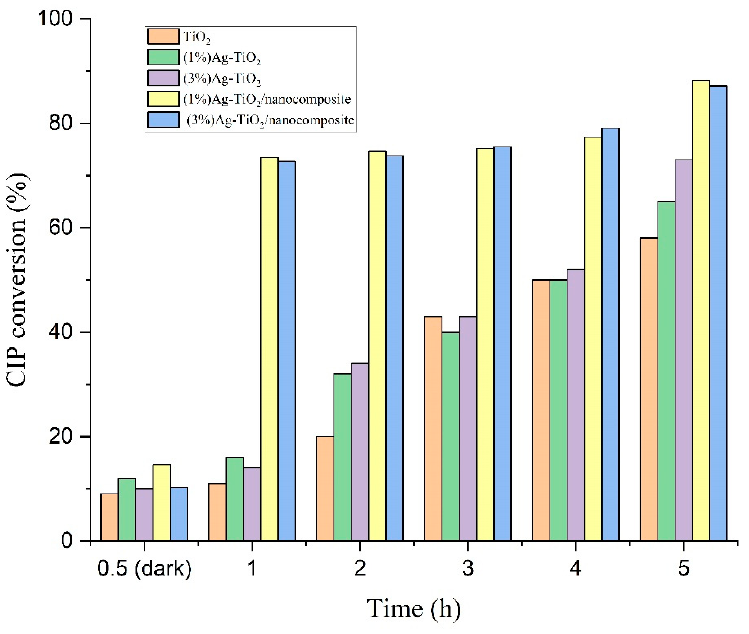
Figure 7. Comparison of photocatalytic activity of varied materials.